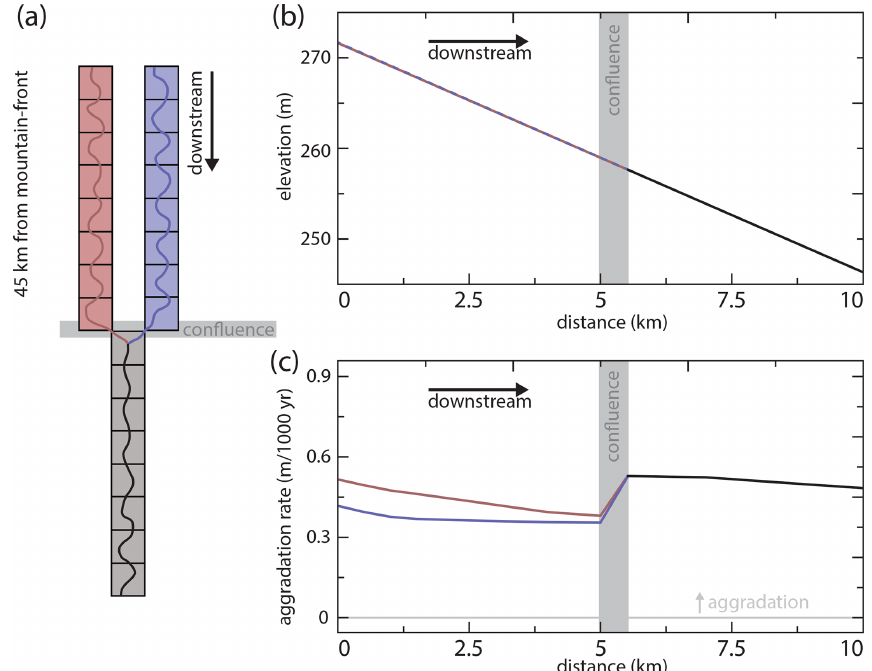
Figure 9. Model experiment showing channel evolution at an abandoned channel confluence. (a) Planform arrangement where the channel avulses between the red and blue pathways whenever normal avulsion criteria are satisfied. (b) Elevations of the red, blue, and gray channel segments upstream and downstream of the confluence. These elevations are not detrended. The blue channel profile is dashed to not obscure the red channel profile. (c) Aggradation rates over a 3000-year period along the three channel segments. Repeated avulsions mean that the red and blue channels alternate deposition, while the gray channel downstream is constantly occupied leading to a faster aggradation downstream of the